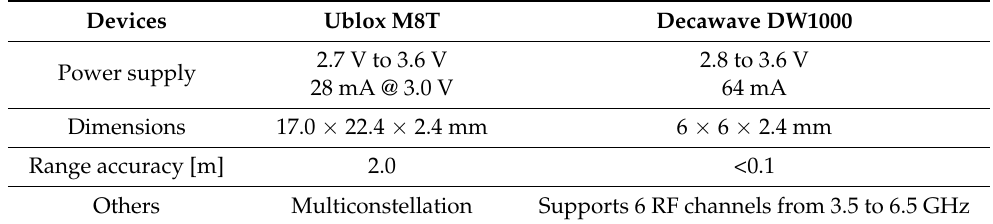
Table 2. Characteristics of the employed hardware.